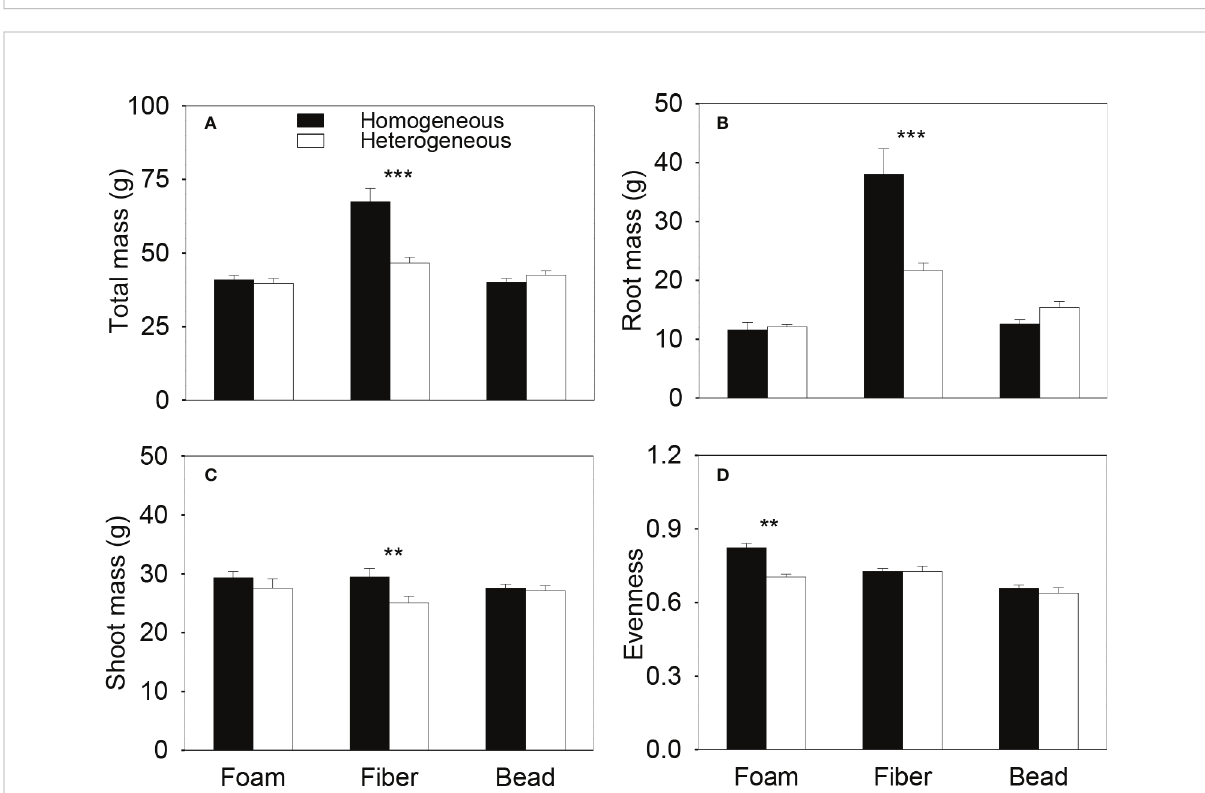
FIGURE 3 (A) Total, (B) root and (C) shoot biomass and (D) species evenness of the plant communities in the homogeneous and the heterogeneous treatment for each of the three shapes of microplastics. Bars and vertical lines are mean and SE. Symbols (*** P < 0.001 and ** P < 0.01) indicate signi fi cant differences between the homogeneous and the heterogeneous